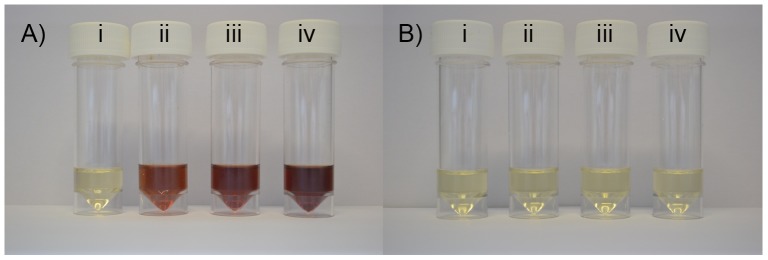
Photochemical reduction of Ag+ in LB medium.AgNO3 was added to (A) LB and (B) LB + 1 mmol dm3 GSH at (i) 0 mmol dm3, (ii) 0.75 mmol dm3, (iii) 1.0 mmol dm3, (iv) 1.25 mmol dm3. GSH, reduced glutathione.